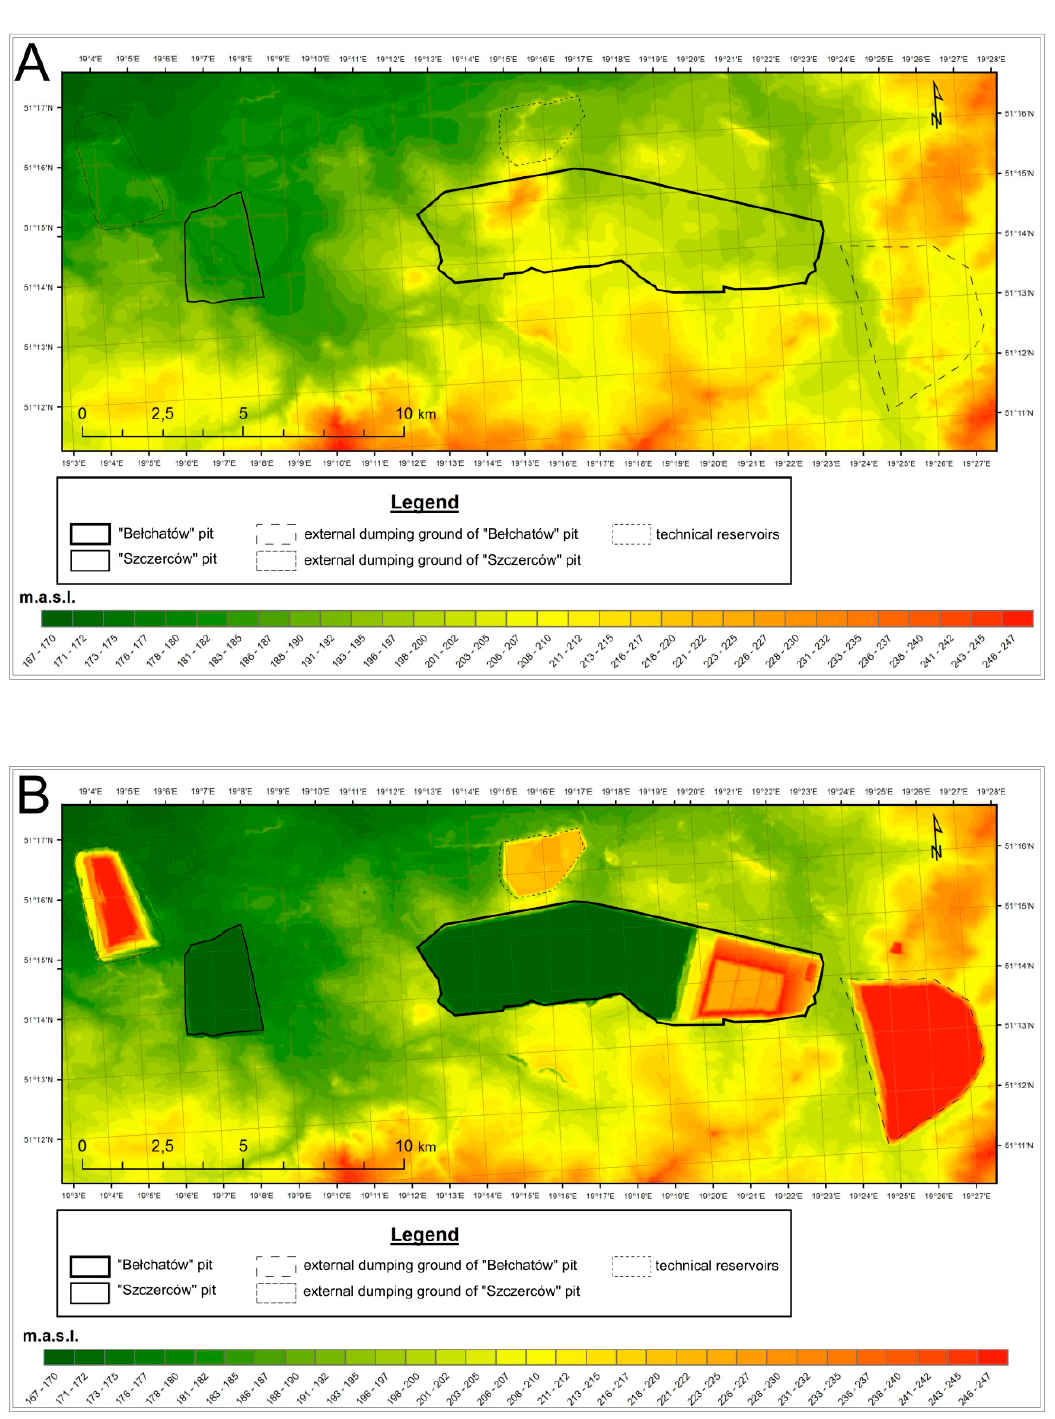
Figure 6. Standardized visualization of the topography in raster form—pre-investment ( A ) and post-investment periods ( B ). Source: Own elaboration.